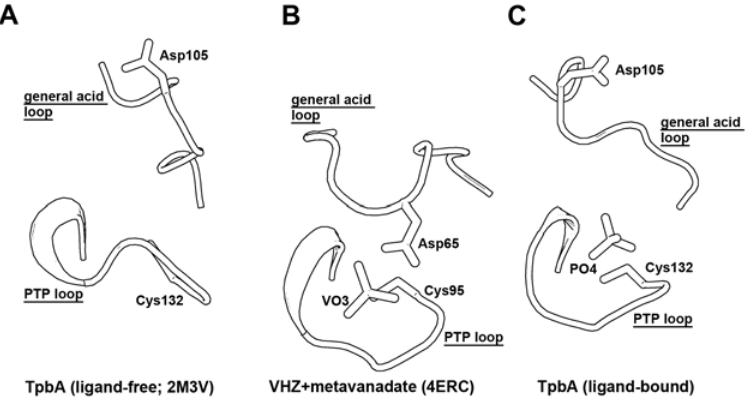
Fig 3. Different states of TpbA. A: The general acid loop and PTP loop of TpbA in the ligand-free state (PDB ID: 2M3V), representing an open state. B: The general acid loop and PTP loop of DUSP23/VHZ in complex with metavanadate (VO3; PDB ID: 4ERC), representing a closed state and showing the catalytically favourable position of the aspartic acid residue. C: The general acid loop and PTP loop of TpbA in the phosphate-bound state, representing a post-catalytic half-open state. The loops are shown in cartoon representation and the catalytic cysteine and aspartic residues are shown in stick representation. All structures are shown in the same orientation after